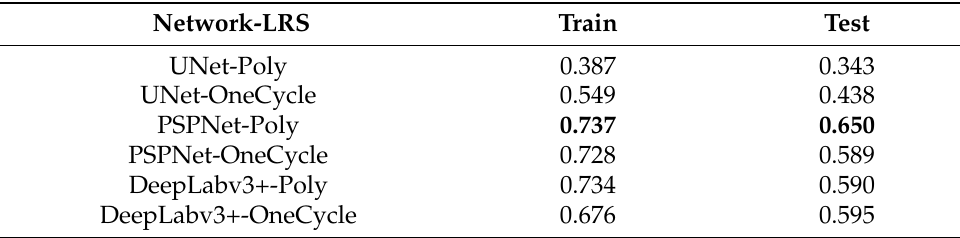
Table 3. Mean Intersection over Union (IoU) obtained through the six experiments on the train and test sets. Numbers in bold represent the best results.